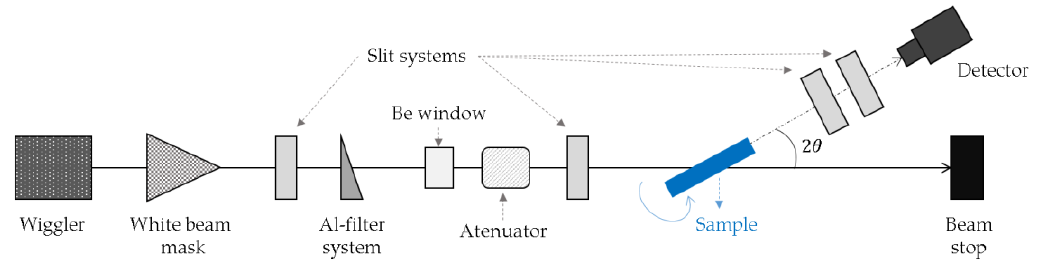
Figure 1. The EDDI beamline at the BESSY II synchrotron light source, adapted from Ref. [25–27]. The white beam crosses a system of slits, filters, and attenuators before hitting the sample at the center of the goniometer. The angle 2 θ was fixed at 1.7 ◦ , all other angles at 0 ◦.